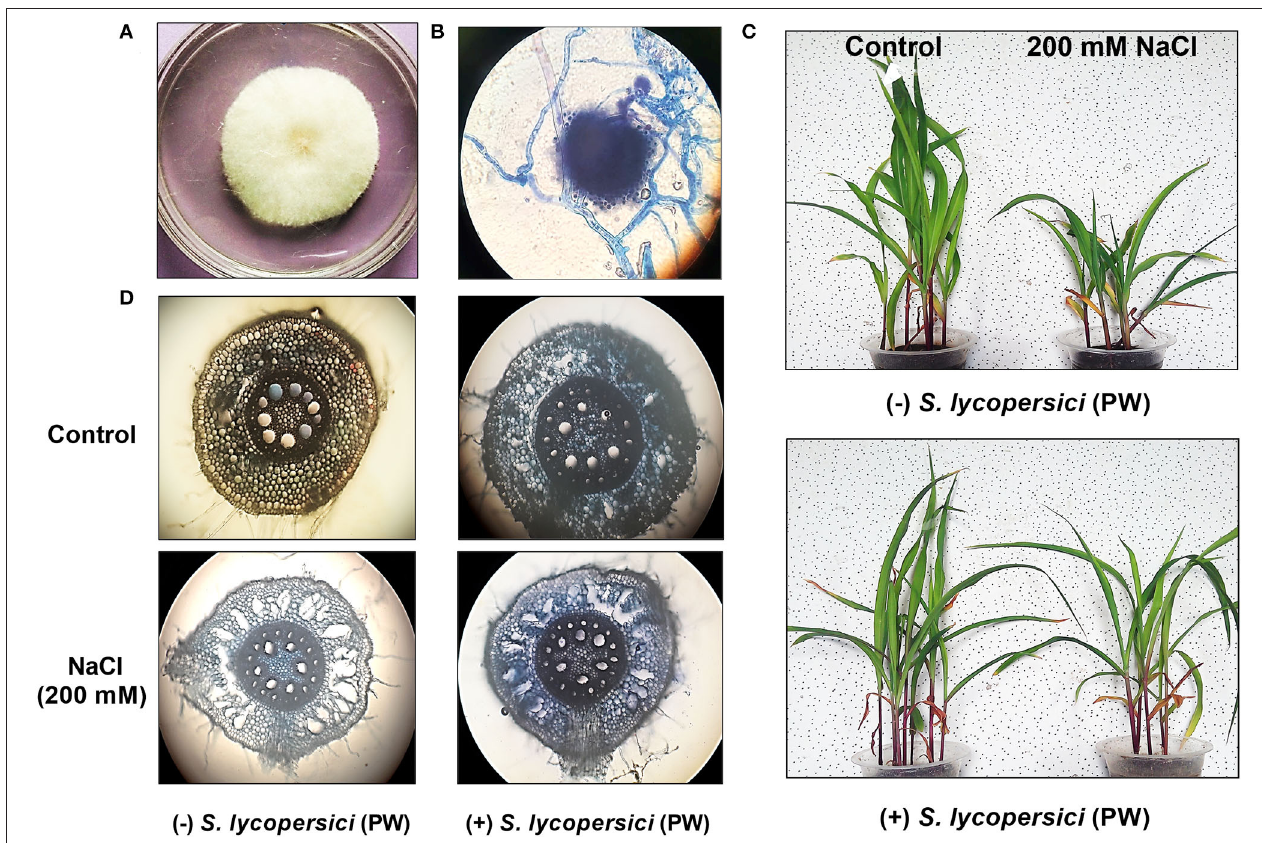
FIGURE 1 | (A) Colony appearance of S. lycopersici (PW). (B) Morphological characteristics of S. lycopersici (PW). (C) Maize plant growth under normal and salt stress conditions without (upper panel) and with (lower panel) S. lycopersici (PW) inoculation. (D) Maize root colonization with S. lycopersici (PW) and root anatomy under normal and salt stress